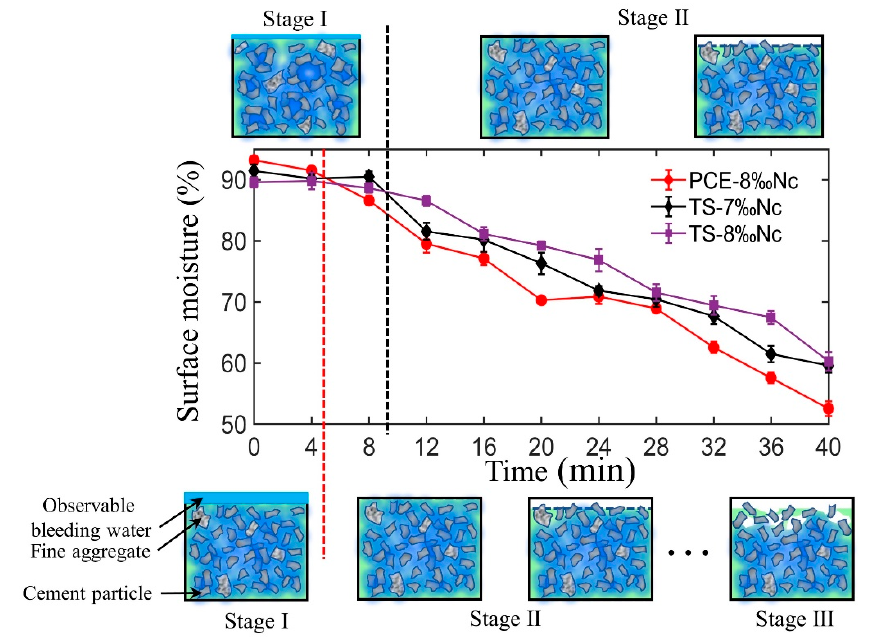
Figure 11. Surface moisture vs. resting time of 3D printed mortar. The schematic diagram of the surface moisture change of the mixture with TS polymer (above) and PCE polymer